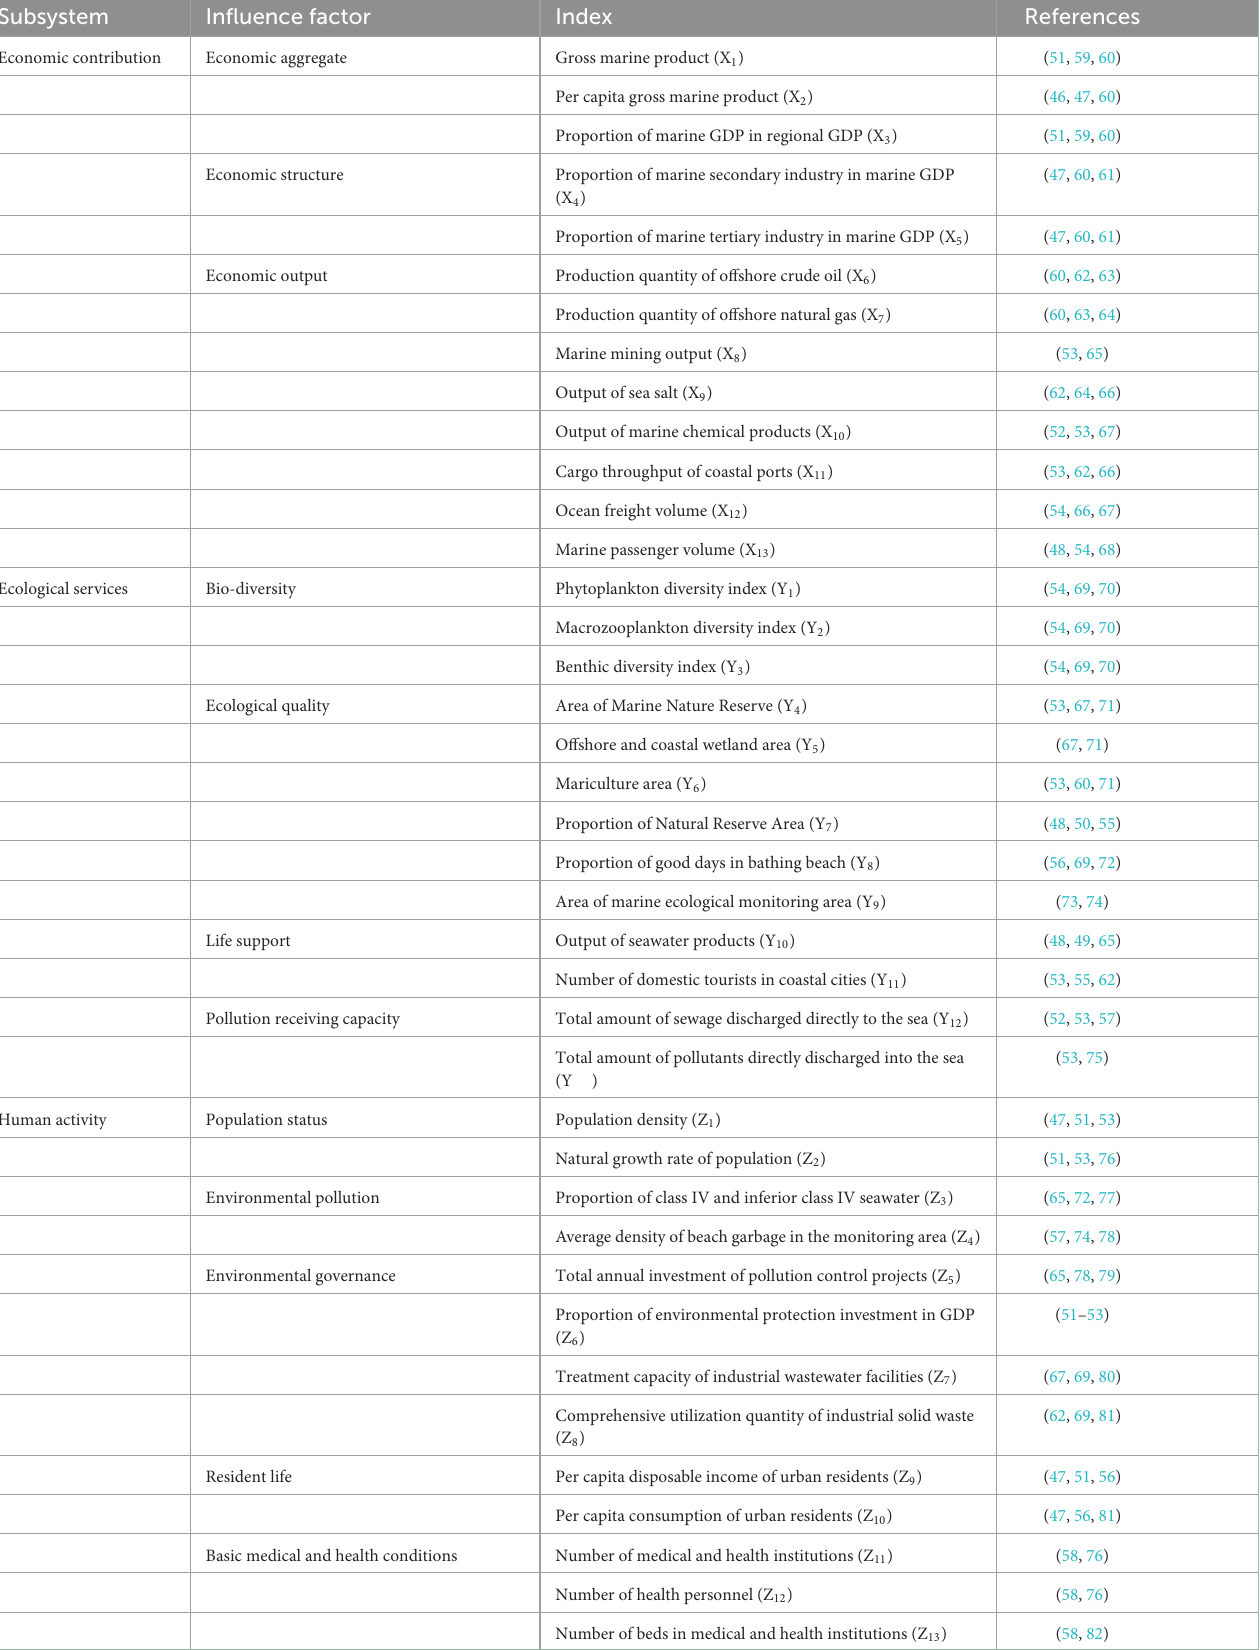
TABLE 5 Evaluation index system of coastal ecosystem carrying